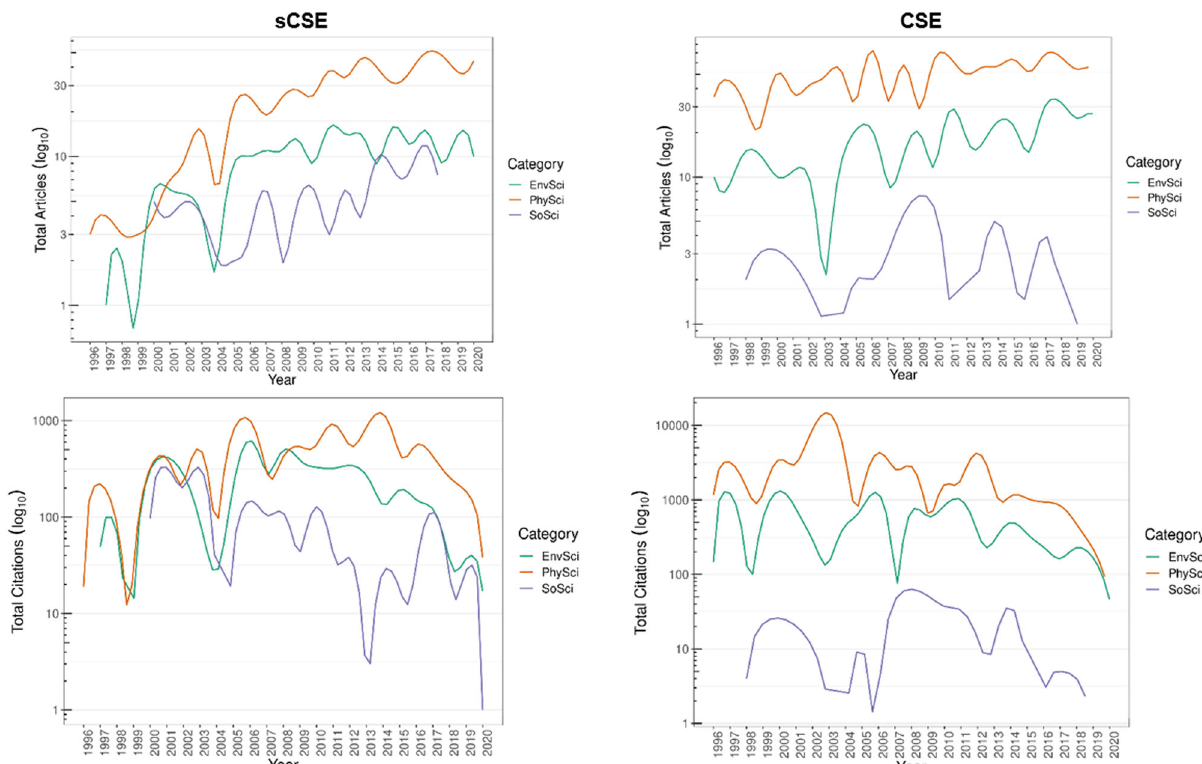
Fig. 3 Total articles and citations by category 1996 – 2020. Left column: sCSE; right column: CSE. Source: the authors based on (Fundación Alejandro Ángel Escobar, 2007, 2020) and Scopus